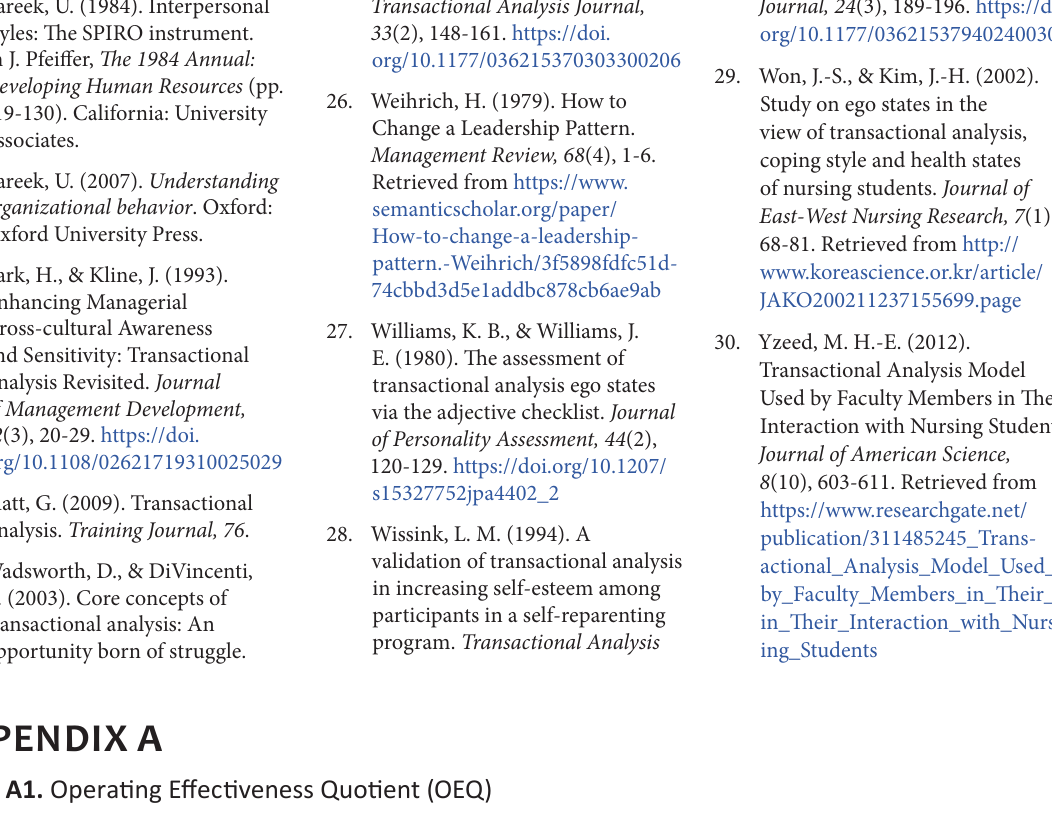
Source: Pareek and Purohit (2018).